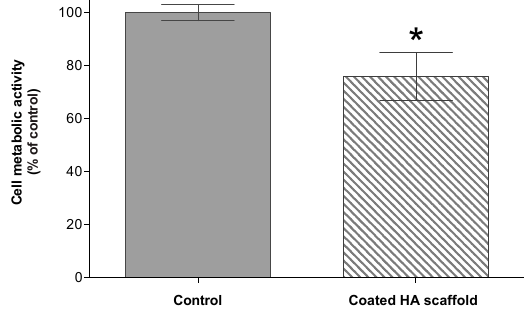
Figure 5. Metabolic activity of human OMECs after three weeks of culture on 3-day old HA scaffold coated with 1 mg/mL collagen IV. Asterisk (*) above the bar denotes significant differences ( p ≤ 0.05) as compared with the control (seeded cells on coated multiwall plates with collagen IV).